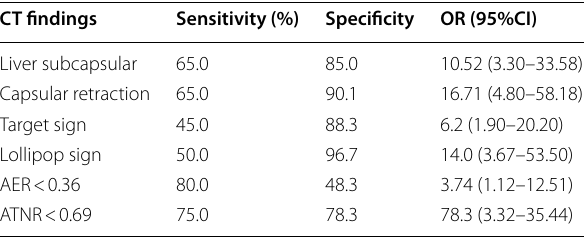
ATNR < HEH hepatic epithelioid haemangioendothelioma, AER arterial enhancement ratio, ATNR arterial tumour to normal parenchyma ratio